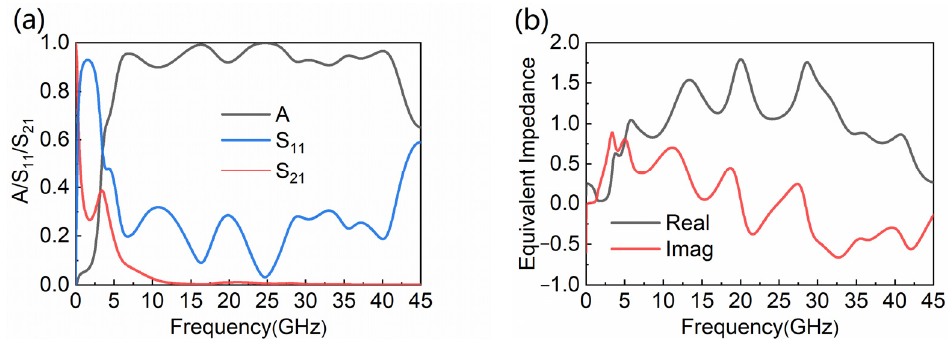
Figure 2. The MA’s ( a ) absorptance, S 11 and S 21 ; ( b ) equivalent impedance.